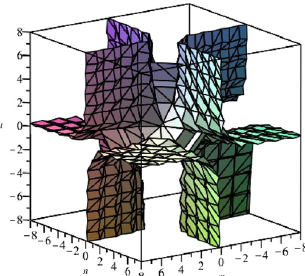
Figure 8: The andic index.